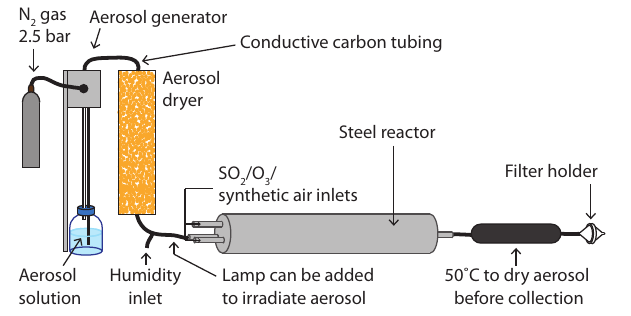
Fig. 1. Experimental set-up used to investigate isotopic fractiona- tion during the oxidation of SO 2 by sea salt aerosol.